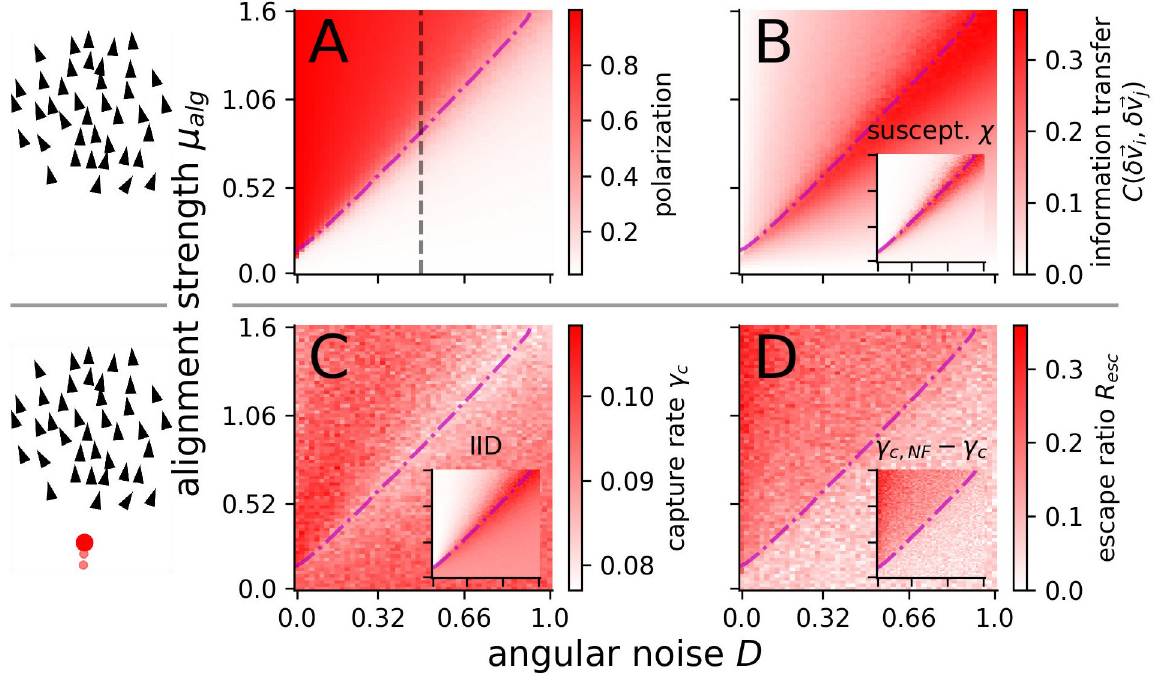
Fig 2. Group optimum. Predation independent ( A, B ) and dependent ( C, D ) group measures. ( A ) Polarization F . The dashed vertical line marks the angular noise of D = 0.5 used in the evolutionary runs. ( B ) Directional information transfer C ð d ~ v velocity fluctuations between interacting agents, peaks at the transition. Inset: Susceptibility, estimated via polarization fluctuations. ( C ) Collective anti-predator performance quantified by the capture rate, which is strongly anti-correlated with the inter-individual distance R = − 0.69 (IID, inset C ). ( D ) Escape ratio R esc = 1 − γ c / γ c , NF . Inset: Difference between capture rates in schools of non-fleeing γ c ,NF and fleeing γ c agents. In all panels: the disorder-order transition is indicated by the dash-dotted magenta line. Each parameter point corresponds to an average over N 40 simulations, each with N = 400 agents attacked for T simu = 120 time units after an equilibration time of T eq = 200. For all insets(B, C, D): colorbars are shown separately in S7 Fig.